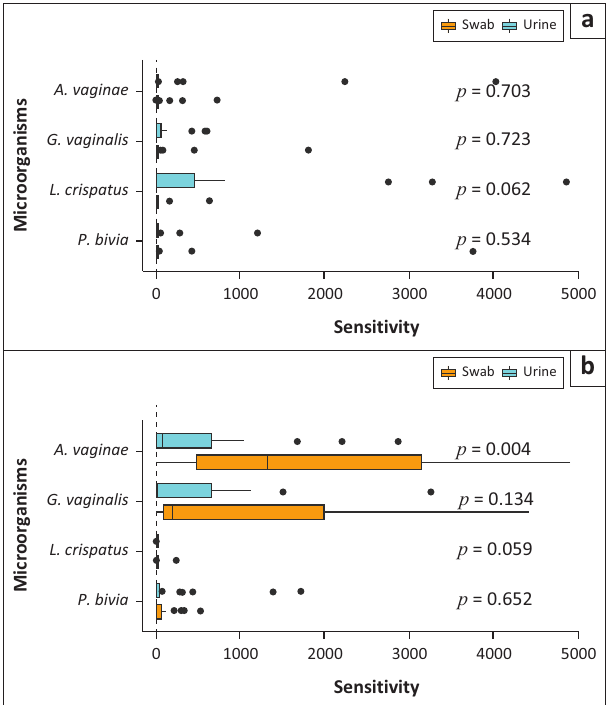
FIGURE 3: Comparison of the abundance of each microorganism in bacterial vaginosis-positive and bacterial vaginosis-negative groups in urine versus swab samples: (a) negative and (b)